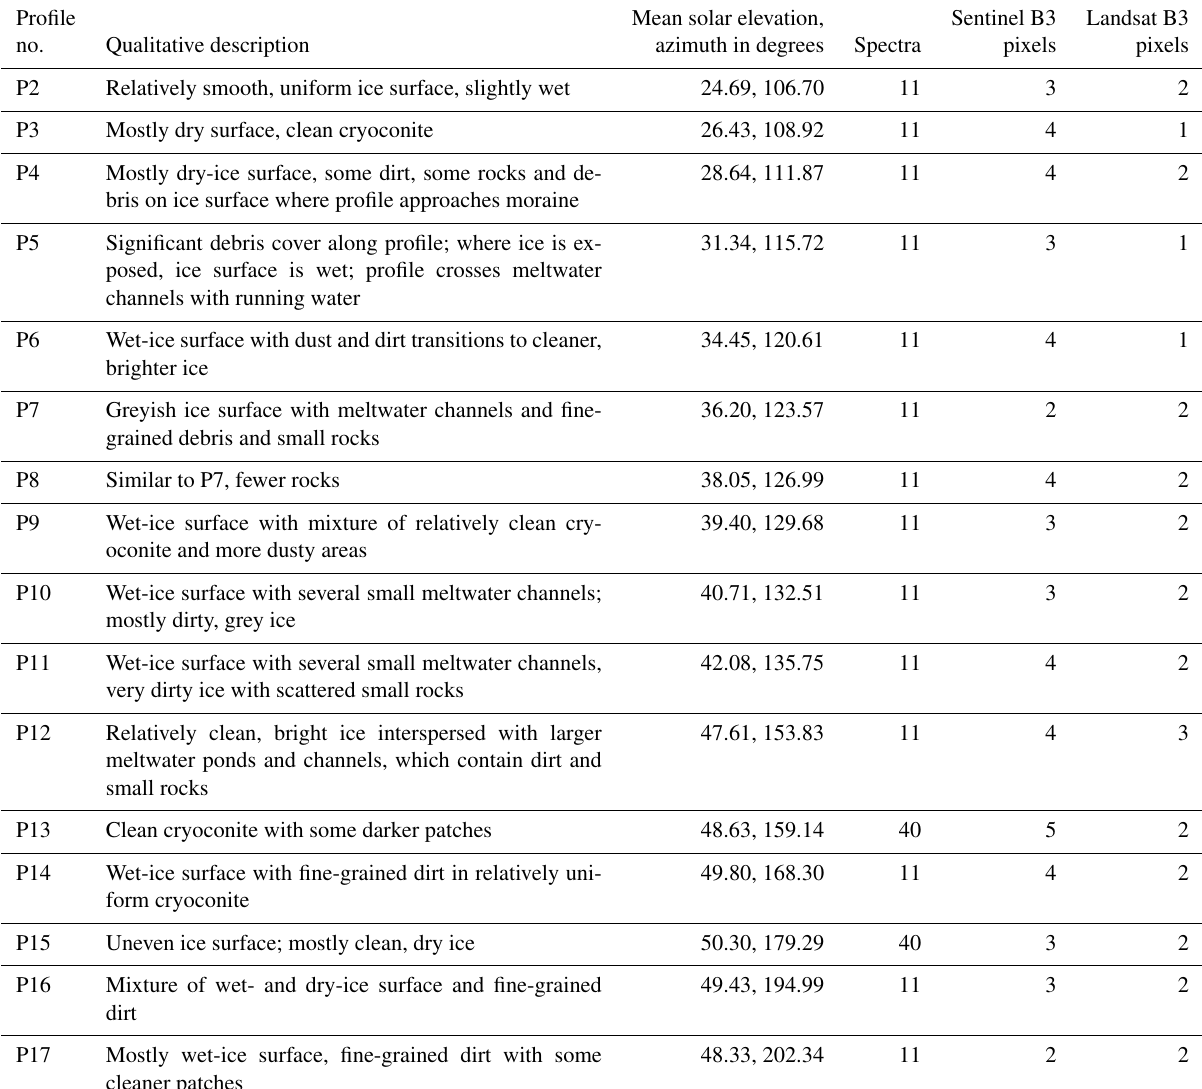
Table 2. Description of the surface characteristics along each profile line, as well as number of spectra collected along the line and number of pixels intersected by the line in band 3 (B3) of the Sentinel and Landsat scenes, respectively. Profile Mean solar elevation, Sentinel B3 Landsat B3 no. Qualitative description azimuth in degrees Spectra